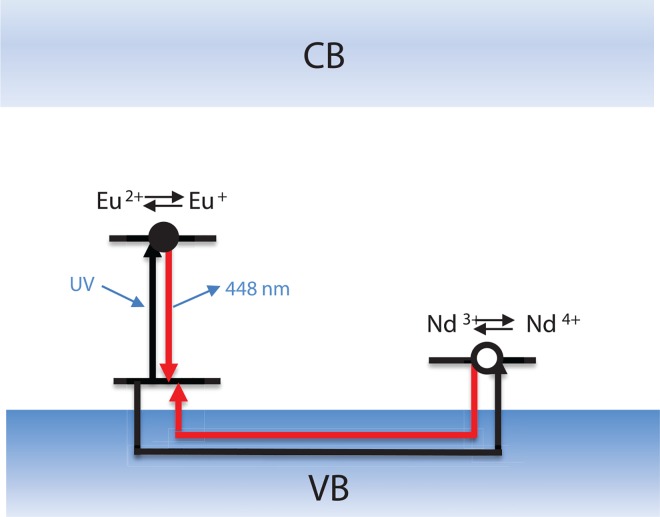
Energy level diagram for CaAl2O4: Eu2+, Nd3+ Phosphor.